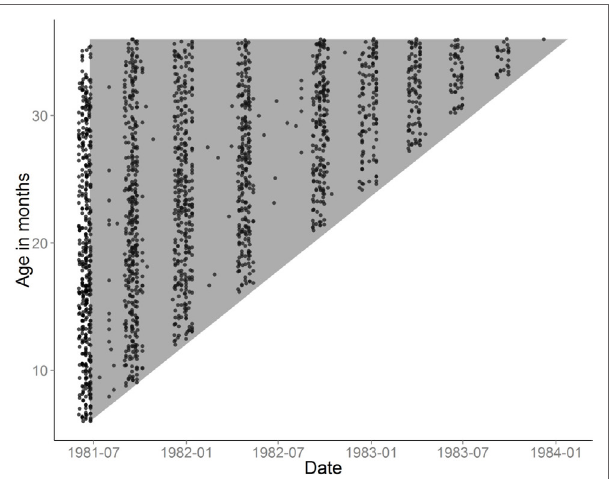
FigUre 2 | Examinations are plotted on the axes of age and calendar time. Each dot corresponds to a weighing examination of a child. The gray triangle illustrates the age groups and periods, where follow-up time was included in the survival analysis. The approximate tri-monthly regime of examinations is visible in the distribution of dots on the horizontal